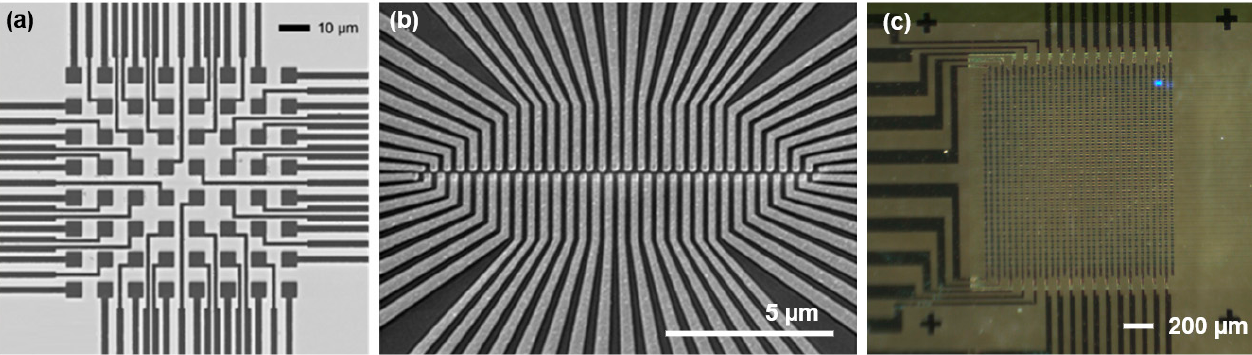
Figure 3. ( a ) Led1: direct addressing LED array chip with 8 × 8 5 µm pixels regularly spaced at 5 µm. ( b ) Led2: 2 × 32 direct-addressing linear array LED chip with pixels sized 200 nm. ( c ) Led3: 32 × 32 matrix-addressing LED array of 20 µm pixel size and pitch.